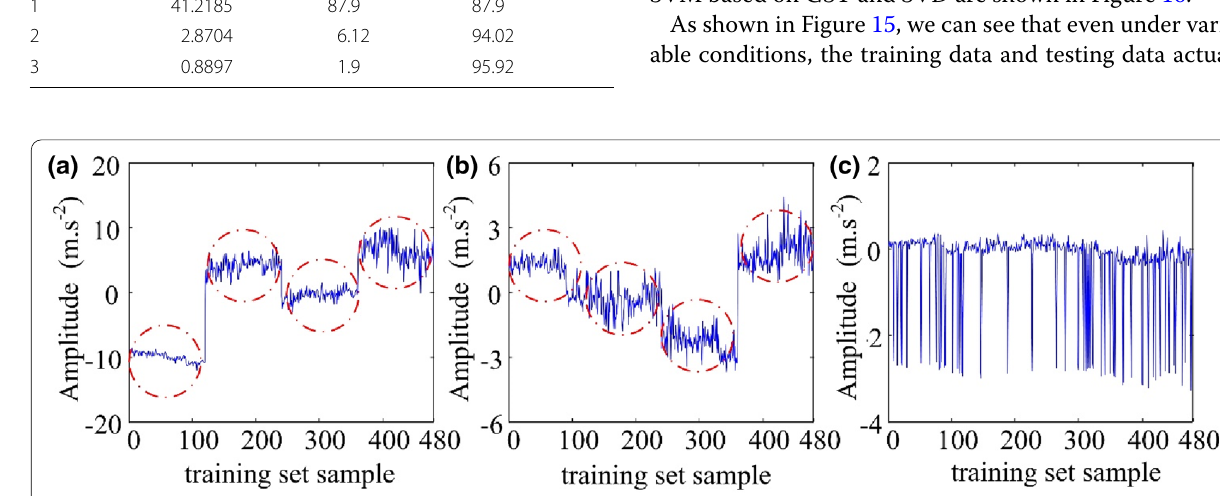
Figure 14 Trend of the first three-order principal components of the training set sample: ( a ) first-order principal component, ( b ) second-order principal component, ( c ) third-order principal